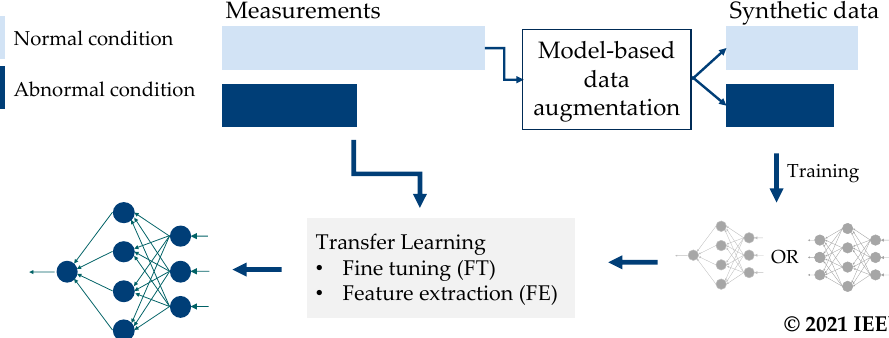
and feature extraction (FE) [30].